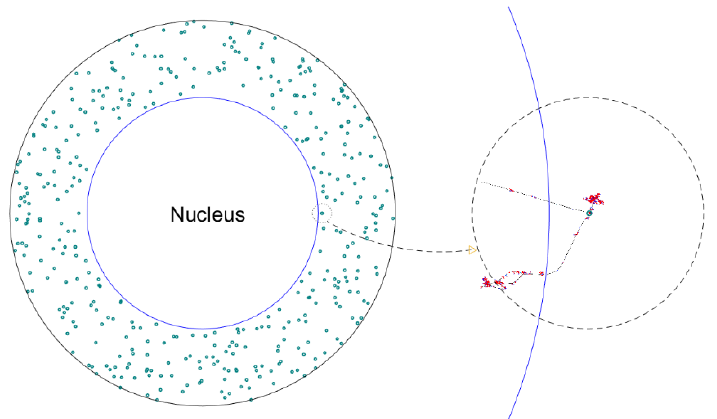
Figure 2. Scoring of the energy deposits in the nucleus. The right dashed circle is a magnified view of the small dotted circle on the left with an NP at the center. It represents an ionized NP in the cytoplasm. To score the energy deposits by the electrons from the NPs, each ionized NP is fixed to the origin in the simulation, and the volume of the nucleus, i.e., the volume that has energy deposits scored, is translated accordingly such that the position of the NP relative to the nucleus is kept the same. In the plot, the blue circle represents the boundary of the nucleus.